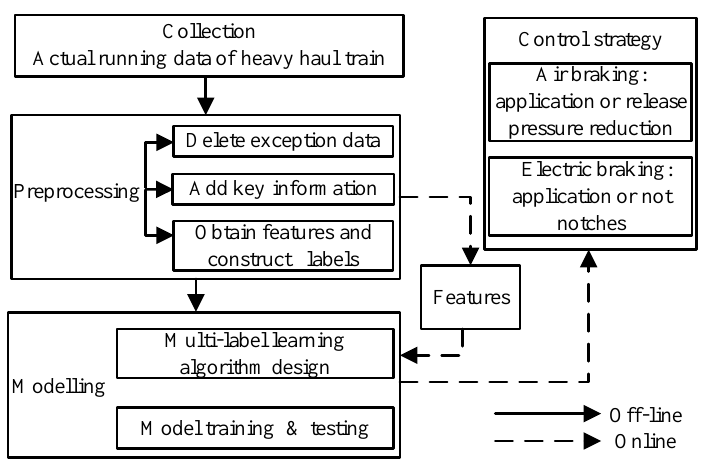
Figure 2. Prediction of control strategy.